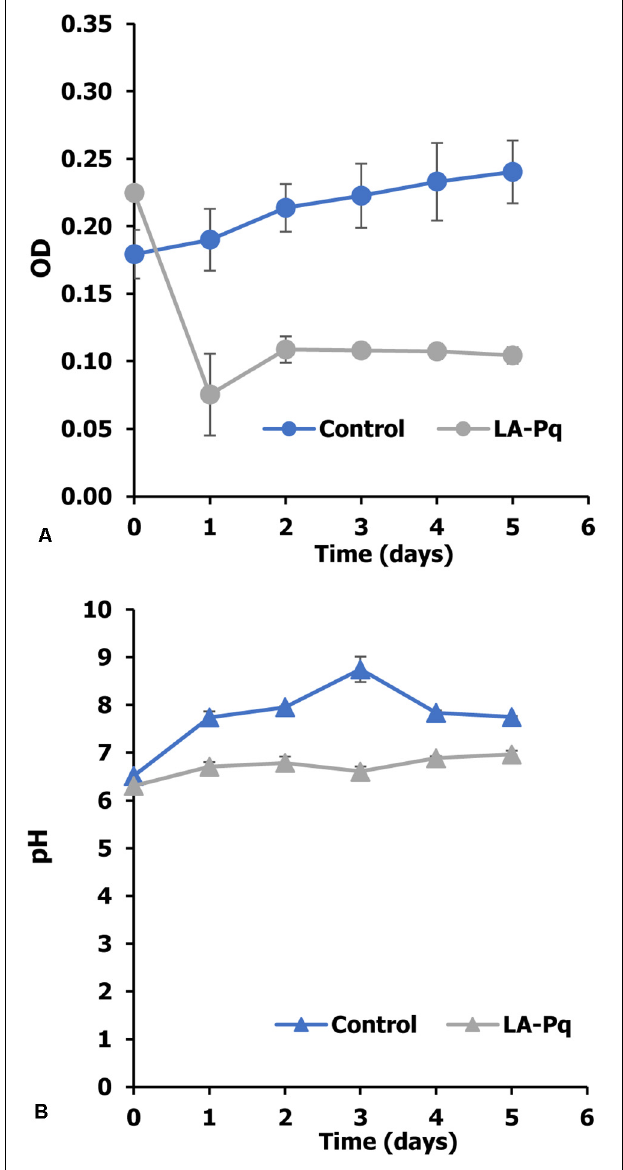
FIGURE 1 | Effect of paraquat on growth of P. duplex AARL G060. (A) Optical density and (B) pH value. LA-Pq: living microalga with